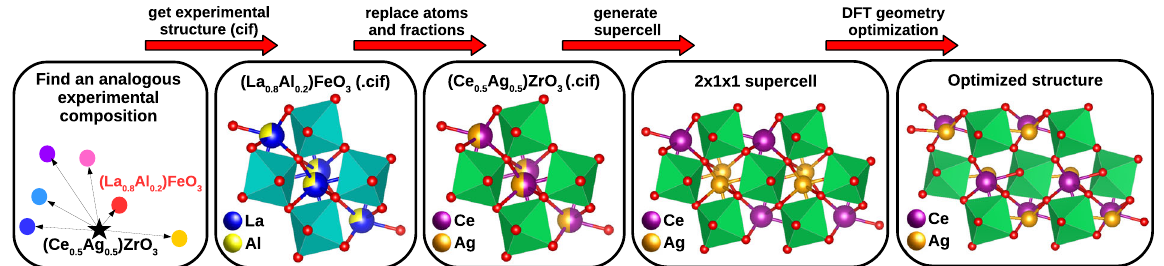
Fig. 6 DFT modelling work fl ow of the composition (Ce 0.5 Ag 0.5 )ZrO 3 . The initial geometry cif (crystallographic information fi le) is borrowed from an analogous experimental material (La 0.8 Al 0.2 )FeO 3 having an orthorhombic Pbnm structure. The atomic species, occupancies and oxidation states were replaced accordingly. A supercell of size 2 × 1 × 1 having the lowest Coulomb energy is selected. DFT optimization of ionic positions, cell volume and cell shape results in an orthorhombic Pmn 2 1 structure, preserving perovskite nature and staring structural